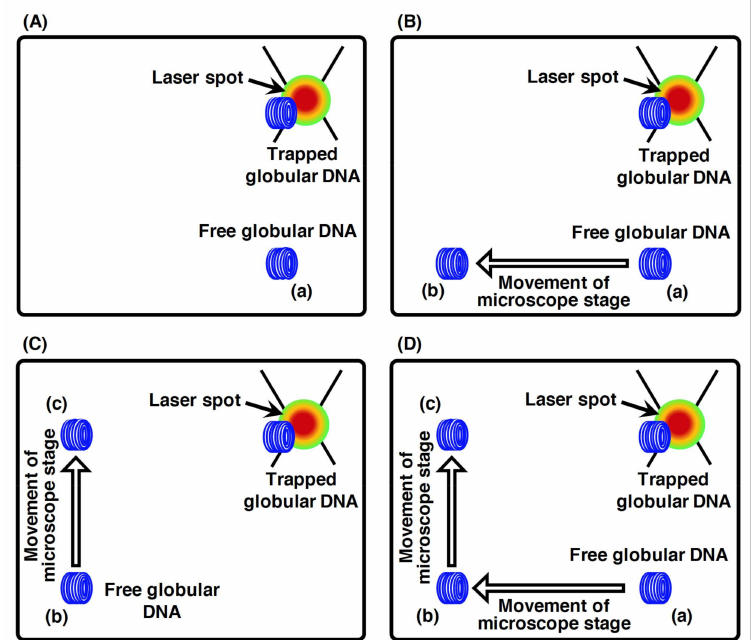
Figure 4. Direct laser trapping of the globular DNA molecule. Schematic illustration of the changes in the positions of free and trapped globular DNA molecules induced by the movement of the microscope stage. ( A ) A globular DNA molecule was trapped by laser. ( B ) When the microscope stage moved to the left, the free globular DNA molecule moved to the left position from (a) to (b) with the movement of the microscope stage. On the other hand, the trapped globular DNA molecule stayed at the upper right position of the microscope stage. ( C ) When the microscope stage moved up, the free globular DNA molecule moved to the upper position from (b) to (c) with the movement of the microscope stage. On the other hand, the trapped globular DNA molecules stayed at the upper right position of the microscope stage. ( D ) Merging of steps A, B and C. Refer to [55] for